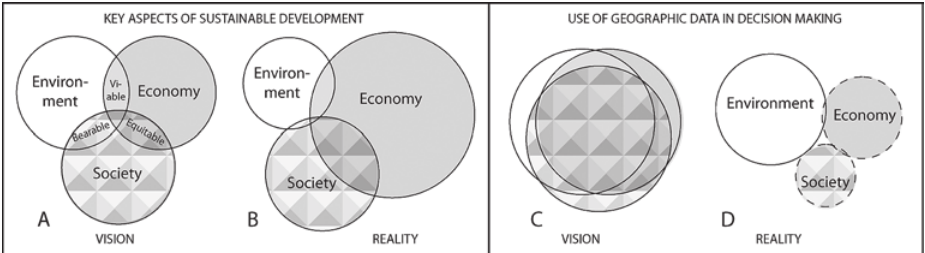
Fig. 1. Data for sustainable development: A – vision in proportion with the expectations, B – actually available, C, D – data used for